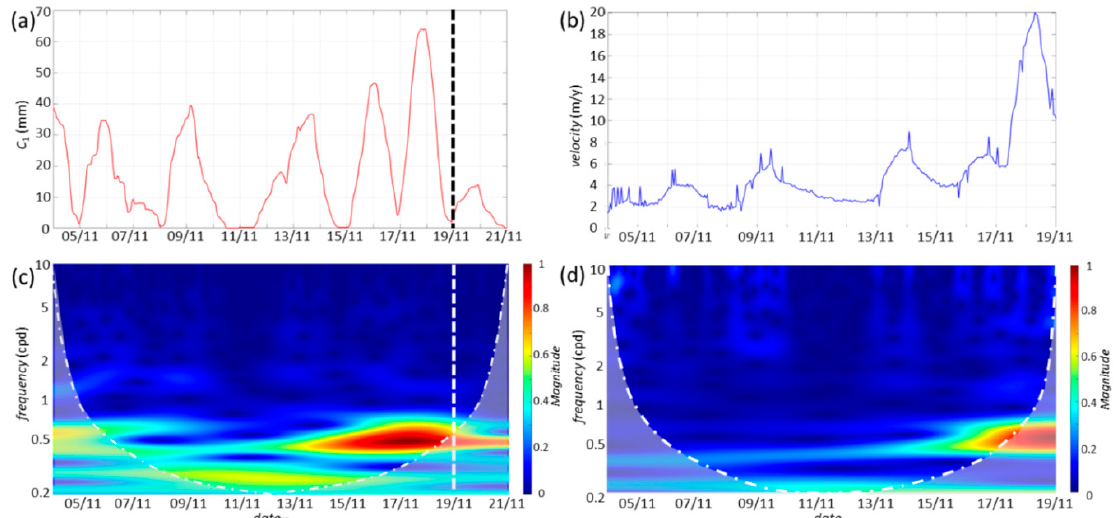
Figure 2. Example of real time series and corresponding scalograms, where cpd means cycles per day: ( a ) rainfall time series; ( b ) velocity time series; ( c ) rainfall scalogram, where the reference day (19 November 2019) is highlighted; ( d ) velocity scalogram. In the scalograms the COIs, whose boundaries are dash-dot lines, are also